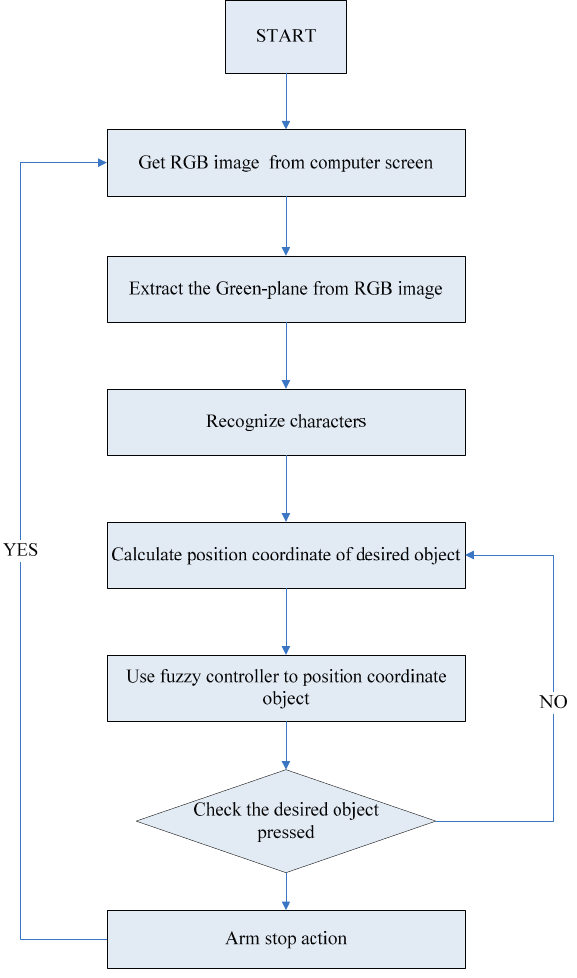
Figure 24. Flow chart of the control